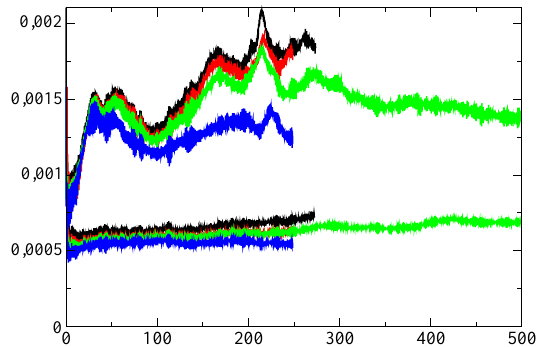
Fig. 5. Upper curves: r.m.s. of the divergence of the upper layer av- eraged the whole domain divided by the r.m.s of the potential vor- ticity anomaly of the upper layer, and the average layer thickness, averaged the whole domain, as a function of time (in days) for exp11 (black) exp21 (red), exp22 (green) and exp23 (blue). Lower curves: same as upper, except that the 30-h time average of the divergence is subtracted to obtain the wave part of the